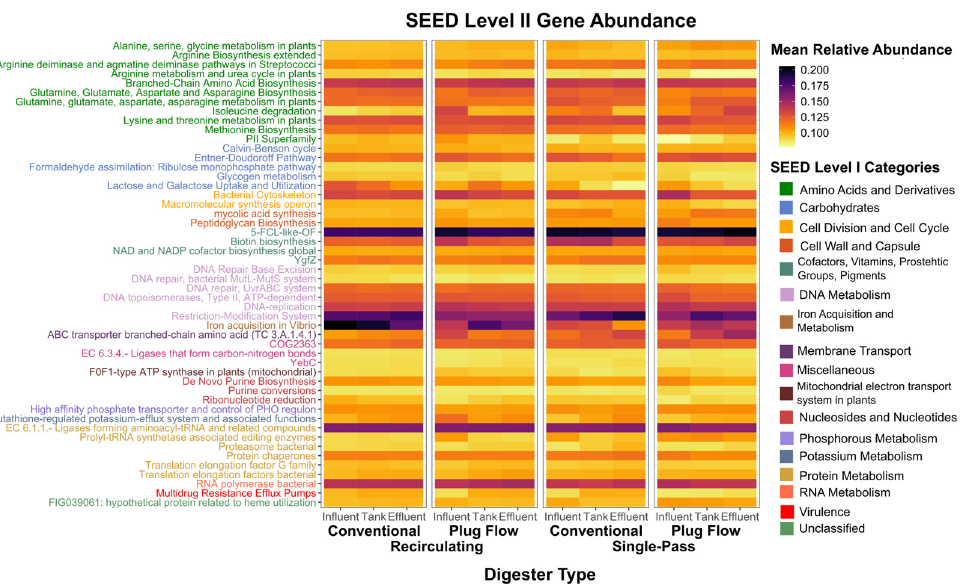
Figure 6. Top 50 most abundant functional gene subsystems (SEED Level III). Level III gene subsys- tems categorized alphabetically by Level I classifications are indicated in color.